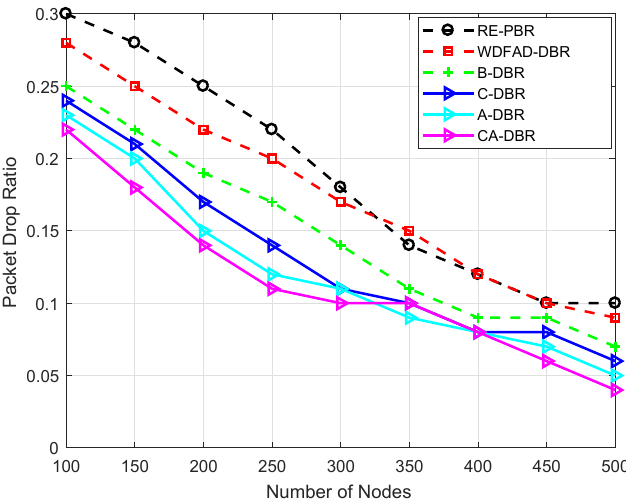
Figure 13. Comparison of the packet drop ratio.